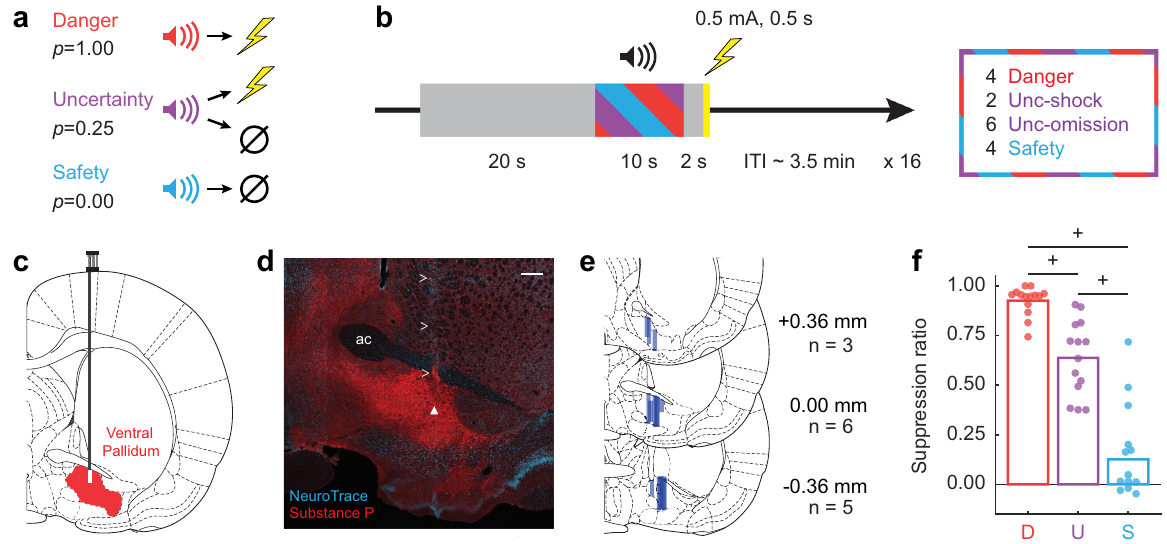
Fig. 1 Fear discrimination, histology, and behavior. a Pavlovian fear discrimination consisted of three auditory cues, each associated with a unique probability of foot shock: danger ( p = 1.00, red), uncertainty ( p = 0.25, purple), and safety ( p = 0.00, blue). b Each trial started with a 20 s baseline period followed by 10 s cue period. Foot shock (0.5 mA, 0.5 s) was administered 2 s following the cue offset in shock and uncertainty shock trials. Each session consisted of 16 trials: four danger trials, two uncertainty shock trials, six uncertainty omission trials and four safety trials with an average inter-trial interval (ITI) of 3.5 min. c After training, a drivable 16 microelectrode bundle was implanted dorsal to the VP. d Example of substance P immunohistochemistry (red) showing the recording track (marked by greater than signs) and the location of the recording site (marked by the white triangle) within the boundaries of the VP (NeuroTrace in blue). Scale bar = 50 µ m; ac, anterior commissure. e Histological reconstruction of microelectrode bundle placements ( n = 14) in the VP are represented by dark blue bars, bregma levels indicated. f Mean (bar) and individual (data points) suppression ratio for each cue (D, danger, red; U, uncertainty, purple; S, safety, blue) is shown for all recording sessions with cue-responsive neurons for all rats ( n = 14). + 95% bootstrap con fi dence interval for differential suppression ratio does not contain